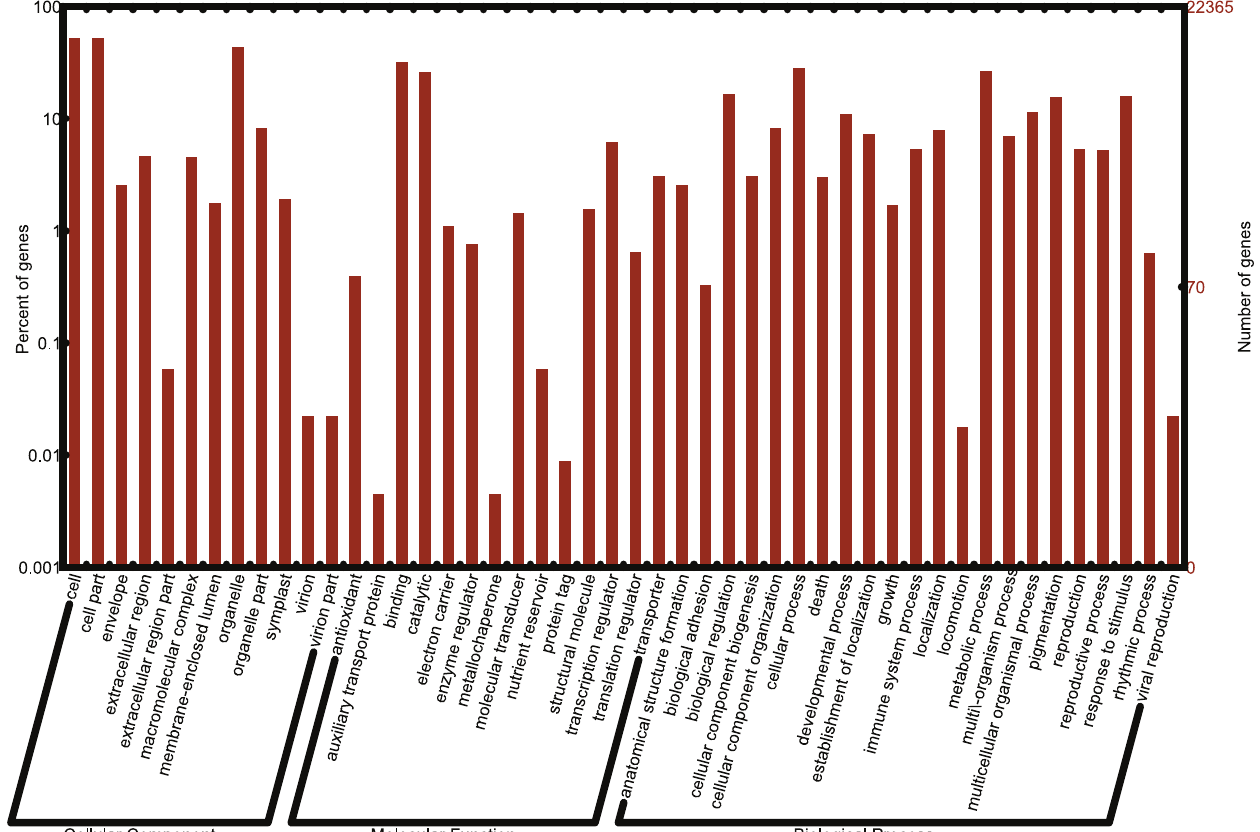
Figure 1. Histogram of GO classifications of the assembled I.indigotica unigenes. Results are summarized in three main GO categories: biological process, cellular component and molecular function.